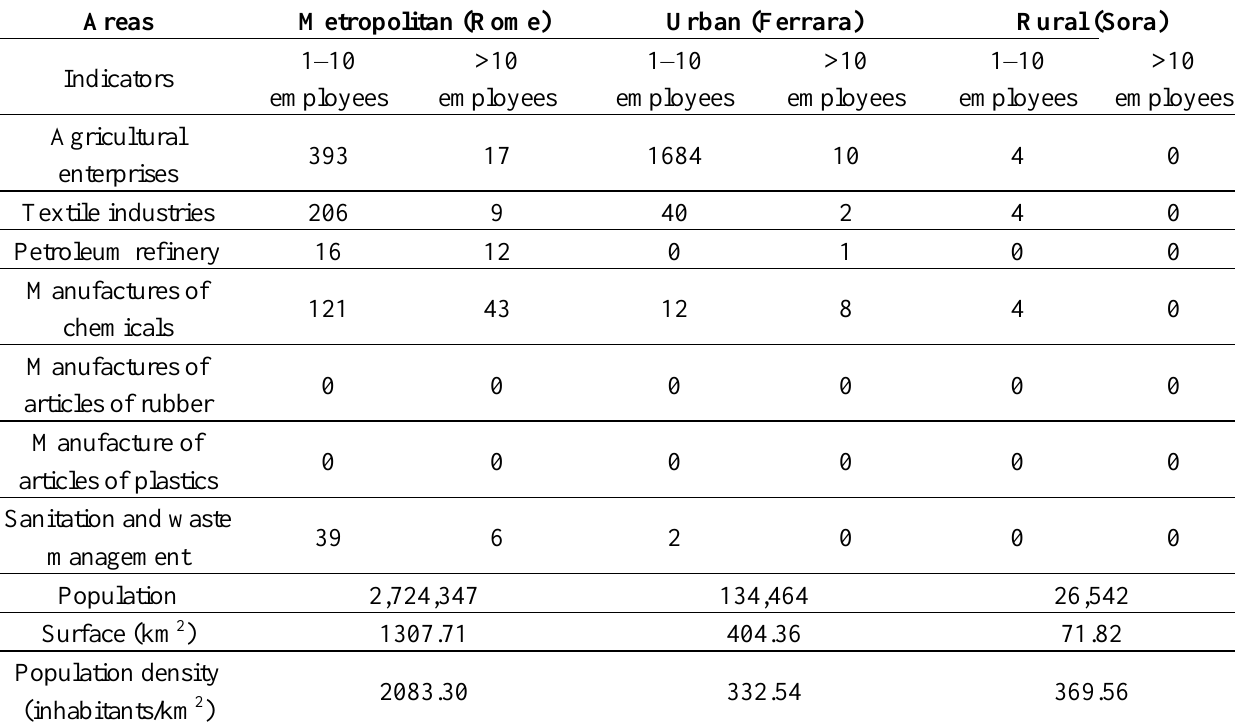
Table 1. Distribution of a set of territorial, demographic and productive indicators in the study areas. Data from the Italian National Institute of Statistics